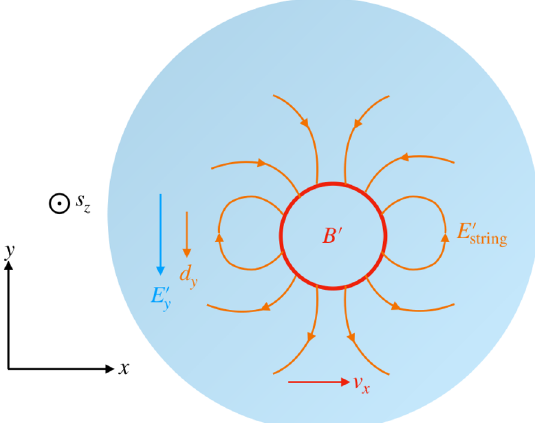
Figure 11 . A vortex aligned in the z -direction accelerates inside a background dark electric field E 0 . The moving vertex (red) has a dipole electric field from a dipole moment of d = − v x Φ D ˆ y